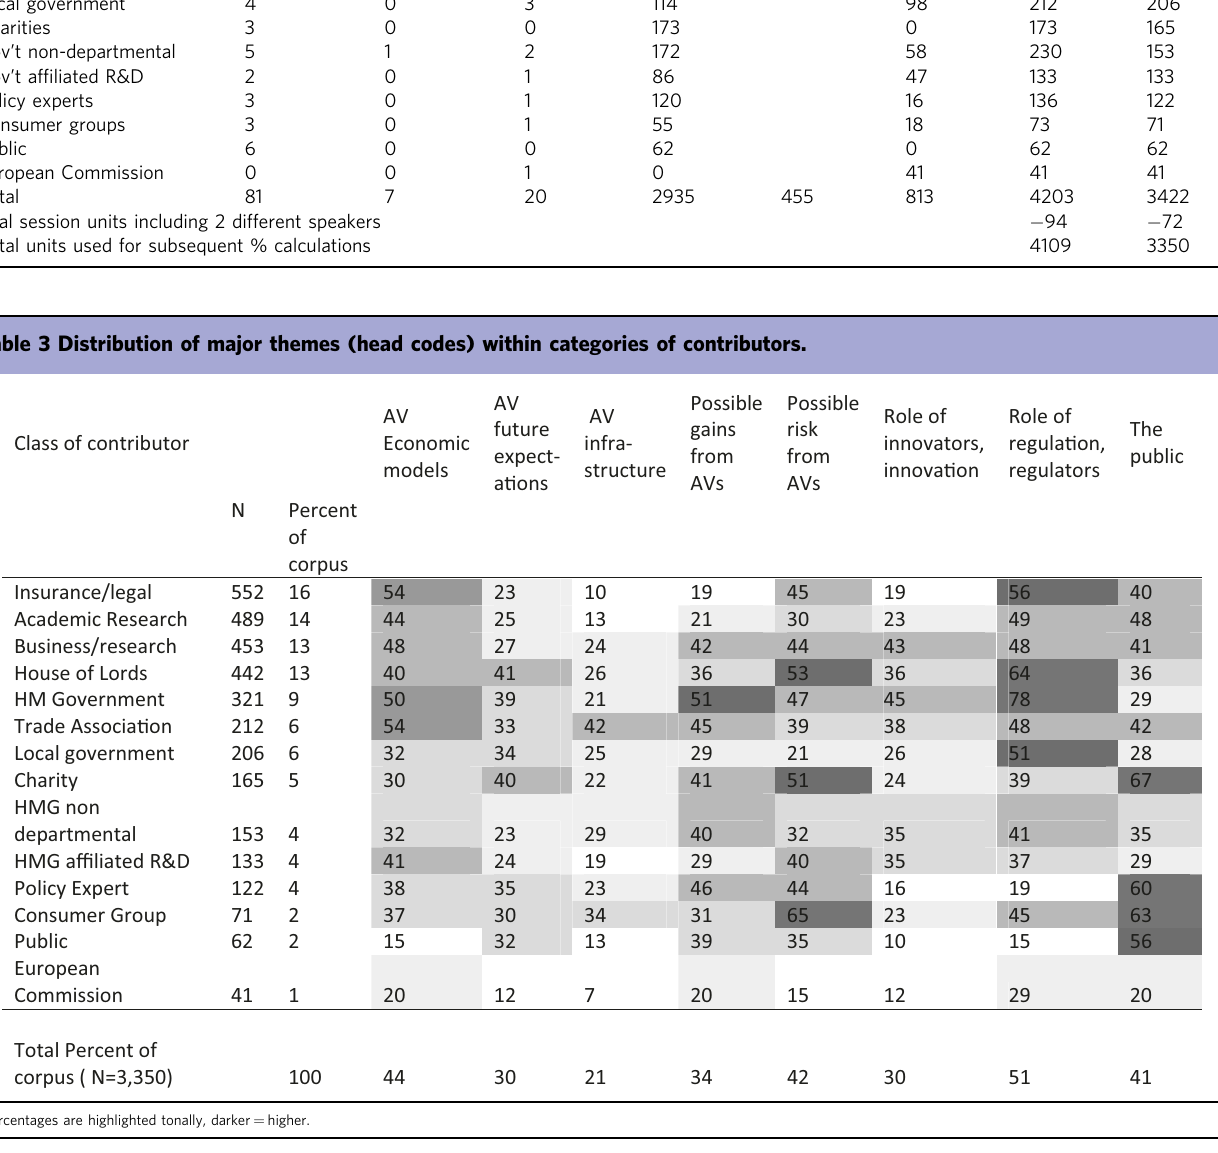
a Percentages are highlighted tonally, darker =